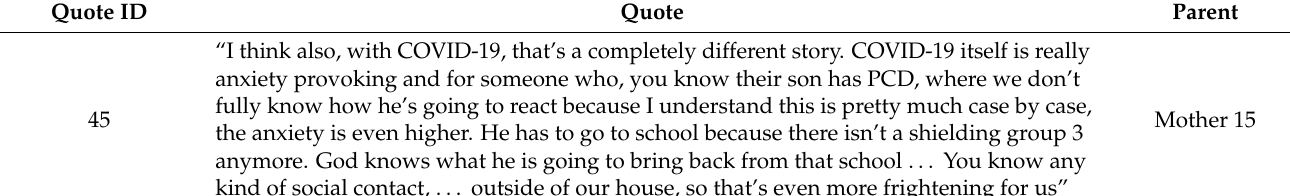
Table 8. Quotes from parents relating to caring for their child during the COVID-19 pandemic. Quote ID Quote Parent